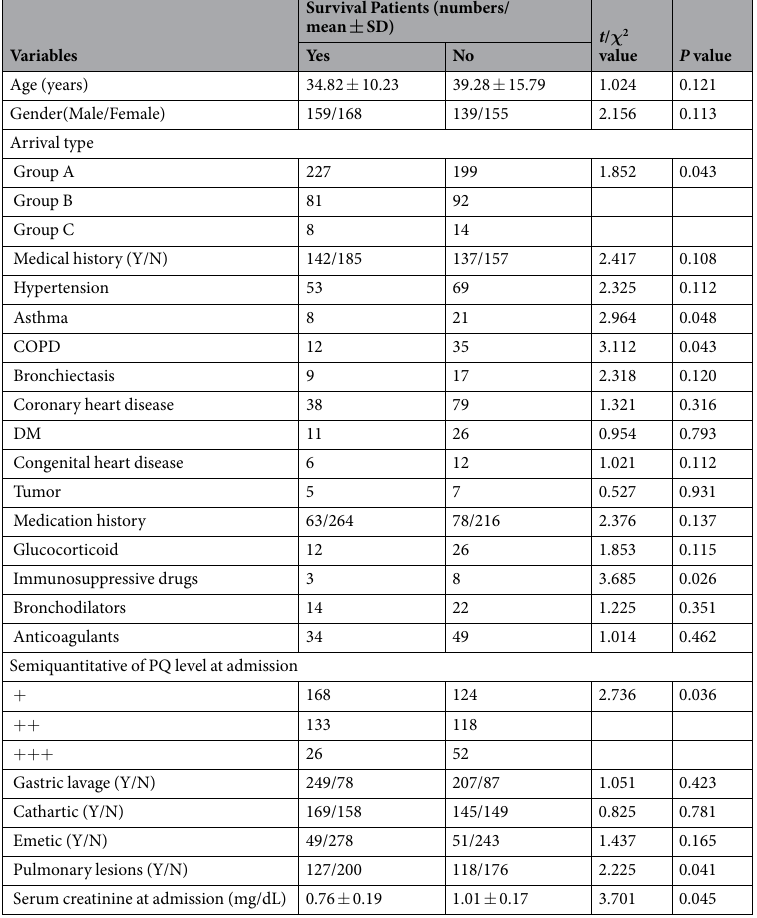
Table 1. Demography data and univariate analysis between survival and death patients. Group A: Patients were directly taken to our institute. Group B: Patients were transferred to us after first aid. Group C: Patients were transferred from more than one hospital. COPD: chronic obstructive pulmonary disease. DM: diabetes